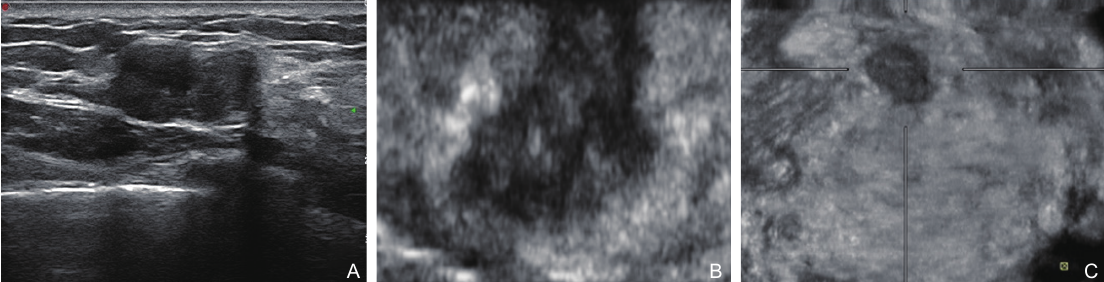
Figure 3 A 37-year old woman with intraductal papilloma in the left breast. (A) Conventional ultrasound showed a hypoechoic lesion (17.5 × 11.0 mm) with irregular shape and circumscribed margin and the final category was BI-RADS 4A. (B) Based on the findings in 3D-US imagings, the final BI-RADS category was BI-RADS 4B. (C) ABVS images did not show the retraction phenomenon in the coronal plane, the final category was BI-RADS 4A. BI- RADS, breast imaging reporting and data system; 3D-US, three-dimensional US; US, ultrasound; ABVS, automated breast volume